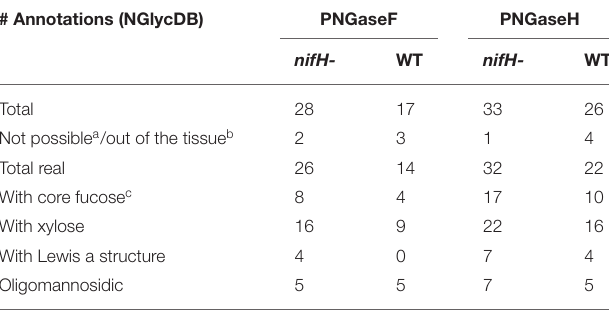
TABLE 1 | The number of annotated N -glycan species from a single cross-section of nifH- and WT soybean root nodule after PNGaseF and PNGaseH + treatment, provided by METASPACE using the NGlycDB and FTICR MS